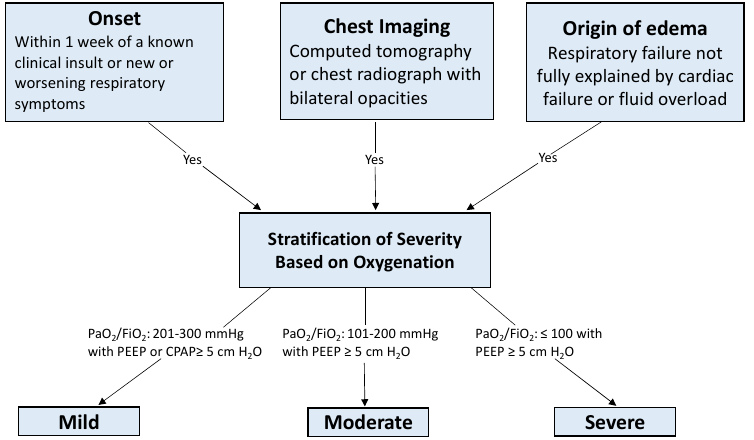
Figure 1. Berlin Diagnostic Criteria [2]. Abbreviations: PaO 2 = arterial partial pressure of oxygen; FiO 2 = fraction of inspired oxygen; PEEP = positive end expiratory pressure; CPAP = continuous positive airway pressure.